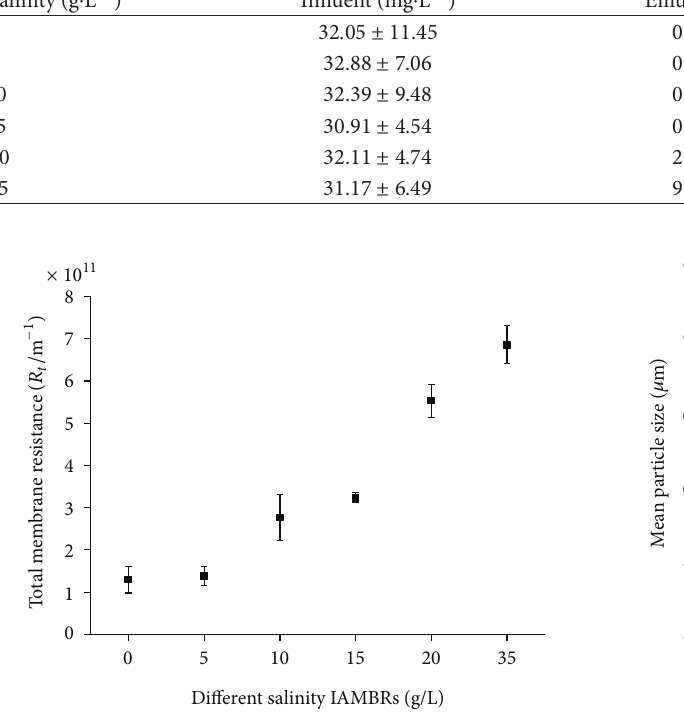
Table 3: Variations and removal efficiencies of NH 4+ -N in five IAMBRs of different salinity during steady operations. Salinity (g ⋅ L −1 )